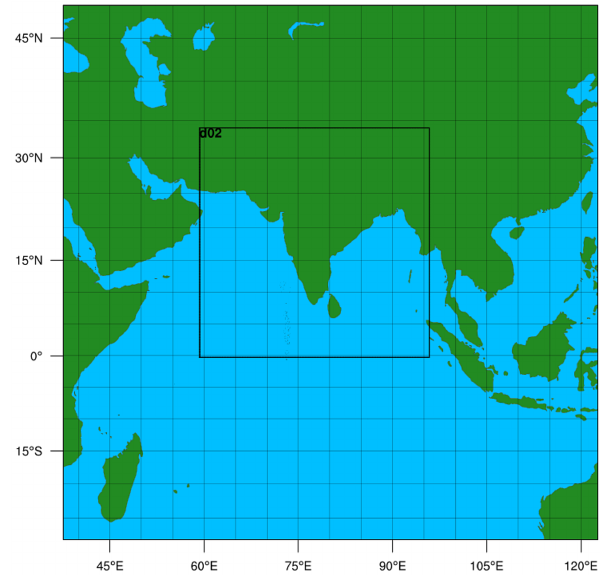
Figure 1. Model domains used in the